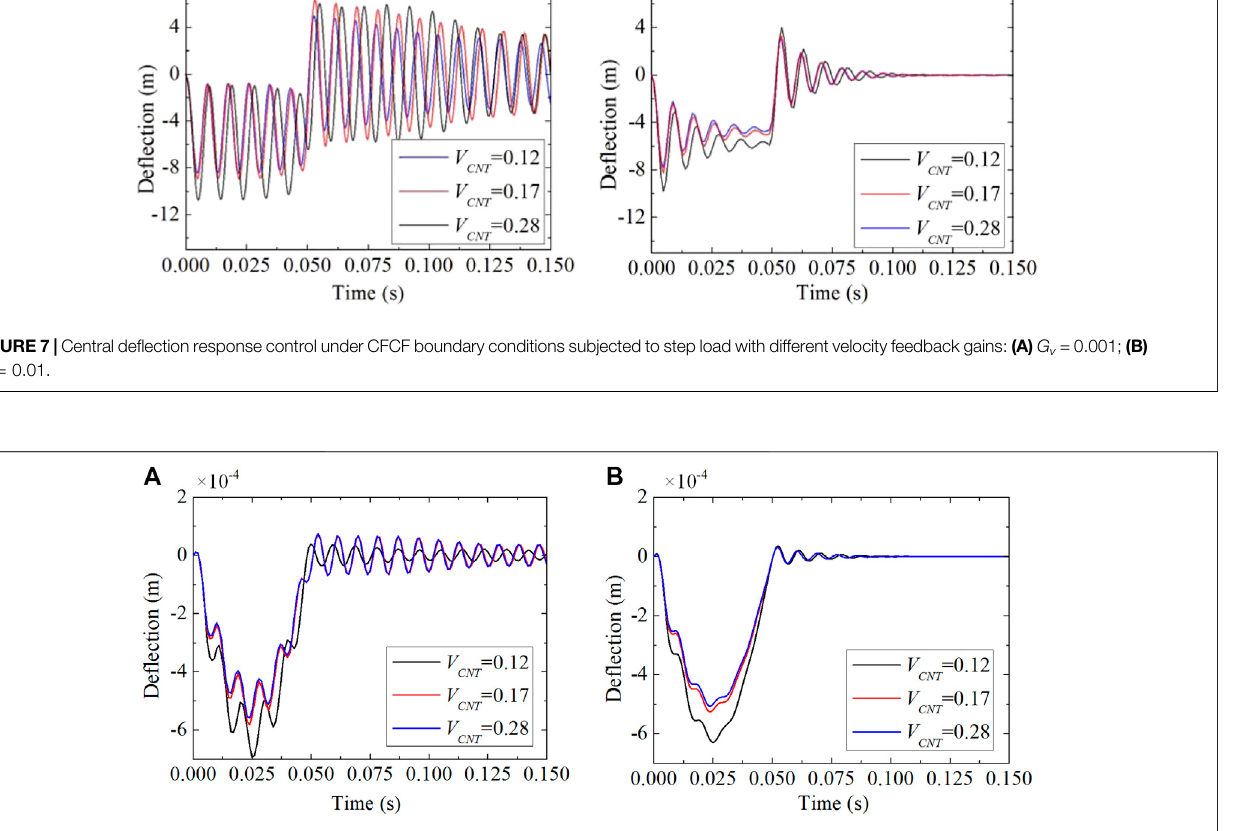
Frontiers in Materials |